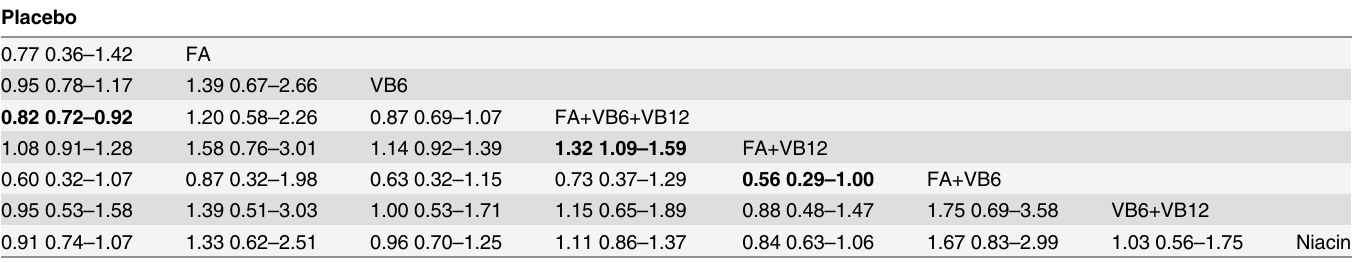
Table 1. Efficacy of the 8 treatments for stroke in network meta-analysis (RR with 95% CrI). Placebo